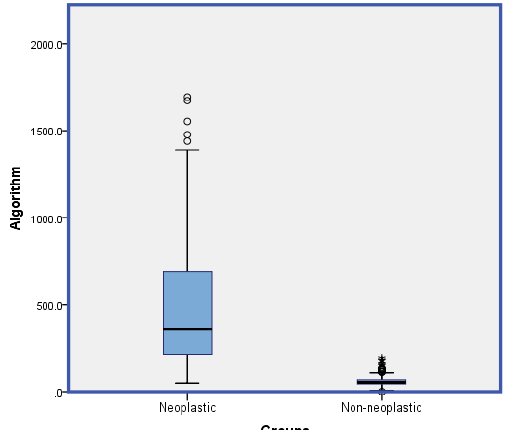
Figure 3. Box and whisker plot for the algorithm [(SD-V-NE*MN-UMALS-LY*SD-AL2-MO)/MN-C- NE] depicting a comparison of the two groups in this study (neoplastic vs. non-neoplastic). The neutrophil parameter, MN-AL2-NE was the only parameter useful in distin- guishing reactive from neoplastic cases with an AUC of 0.948 at a cut-off point of 147.5, with sensitivity of 78.47% and specificity of 80.43% (Figure 4). Box and whisker plots il- lustrating the MN-AL2-NE parameter were generated for the neoplastic group versus the reactive group (Figure 5) and for all subtypes in neoplastic group versus the reactive group (Figure 6).